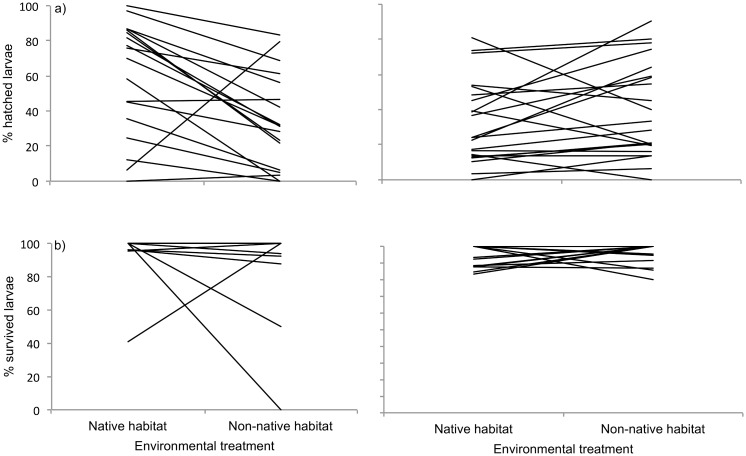
Genotype by environment interactions as indicated by pairwise within-family comparisons of a) hatching success (%), and b) survival through yolk sac phase (%) of Esox lucius depending on habitat translocation treatment (native vs non-native).Figure show results for Okne to the left and Lervik to the right. After removal of the outlier families showing the largest differences between treatments (one outlier for each of the Okne plots), the effect of translocation treatment still depended on family both for hatching success (χ2 = 1068, df = 1, P = 0.006) and survival through yolk sac phase (χ2 = 74.73 df = 1, P < 0.0001) in the Okne population.